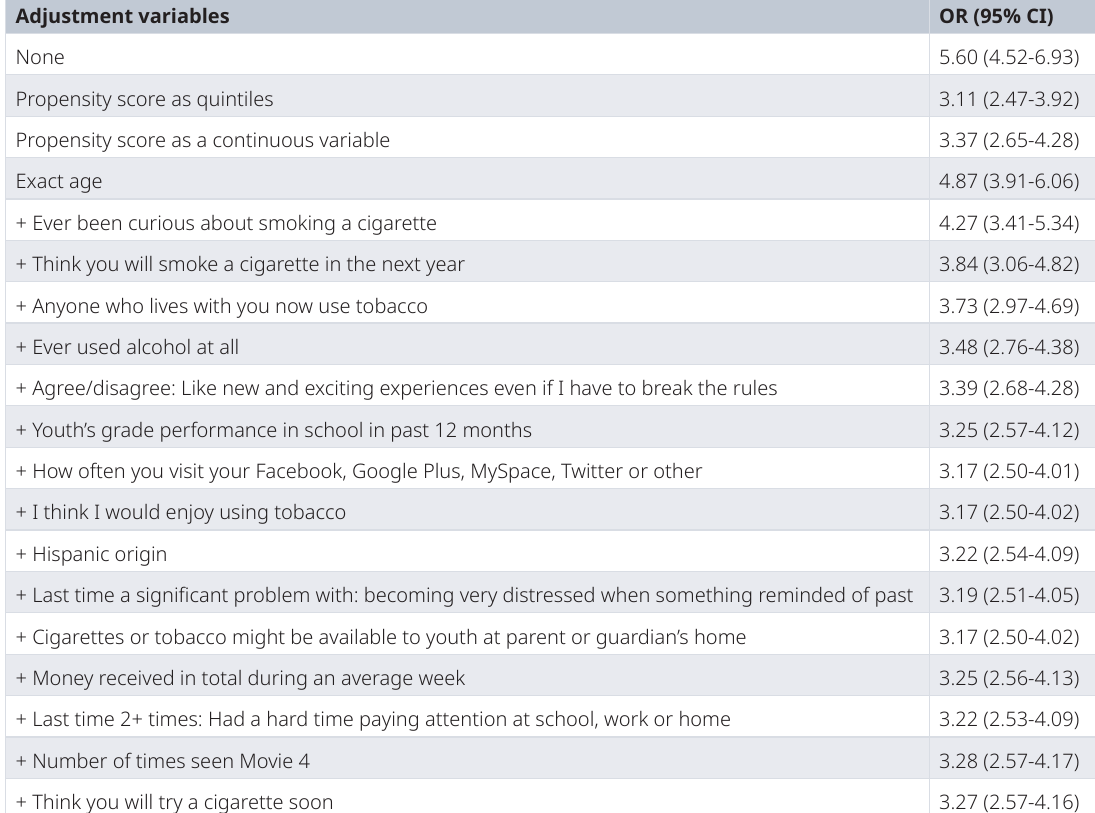
Table 2. Relating Wave 3 ever smoking to Wave 2 ever e-product use (Main analysis